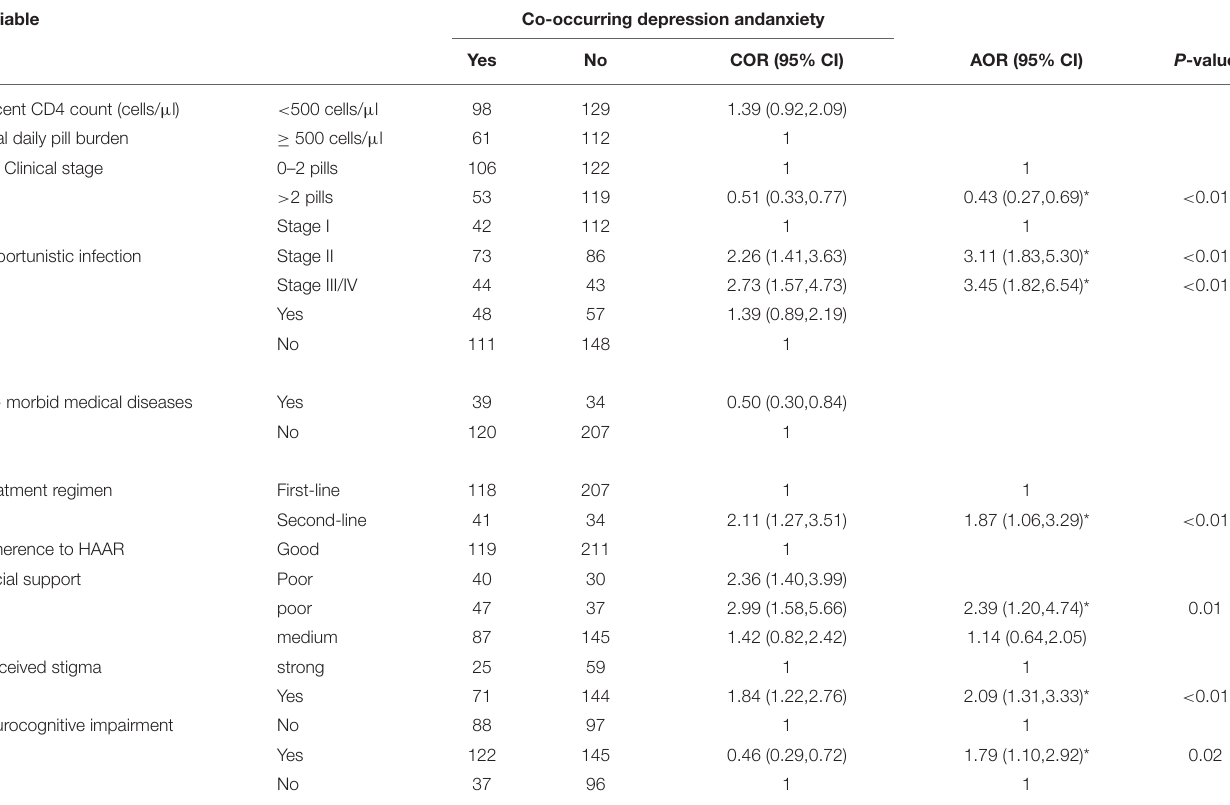
TABLE 5 | Bivariate and Multivariate analysis of variables associated with co-occurrence of depression and anxiety among PLH attending at public health institution in Bahir Dar, Ethiopia, 2016 ( n = 400).